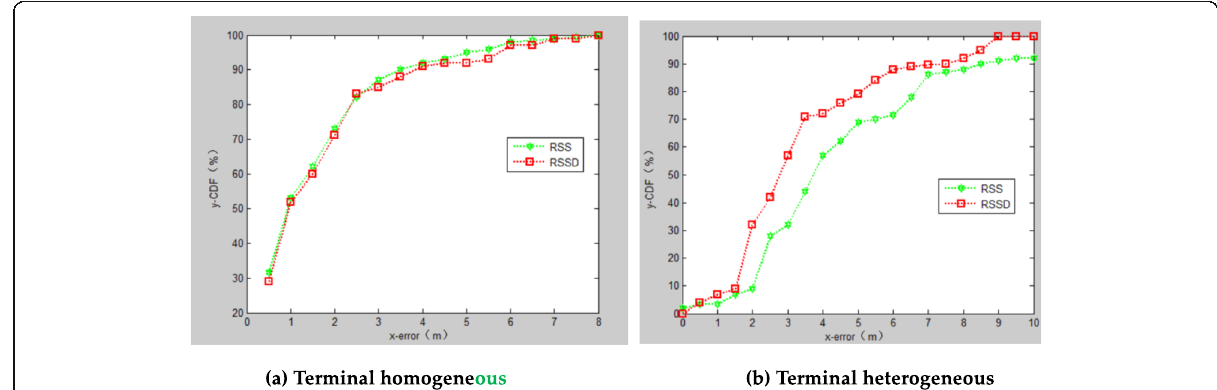
Fig. 5 Comparison of RSS and RSSD localization performance. a Terminal homogeneity. b Terminal